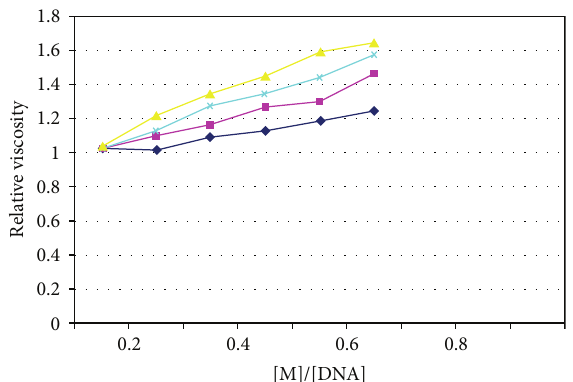
Figure 3: Effect of increasing concentrations of the complexes on the relative viscosity of CT-DNA at 25 ∘ C.